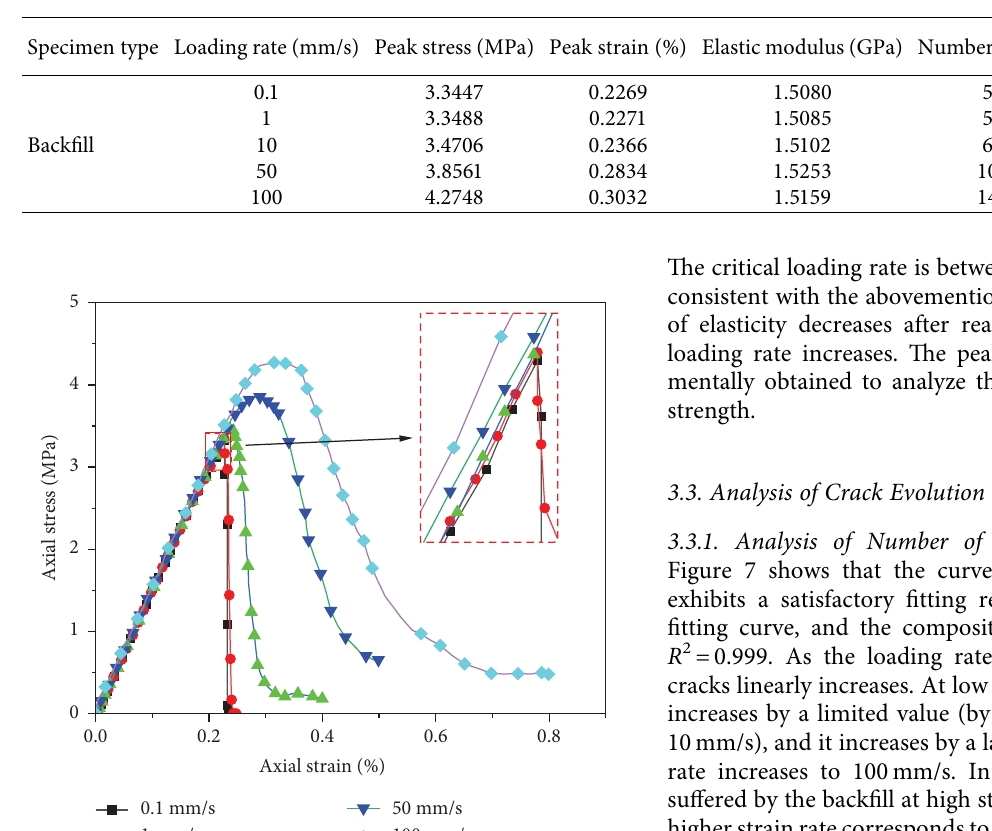
Table 2: Numerical calculation results of the backfll model.